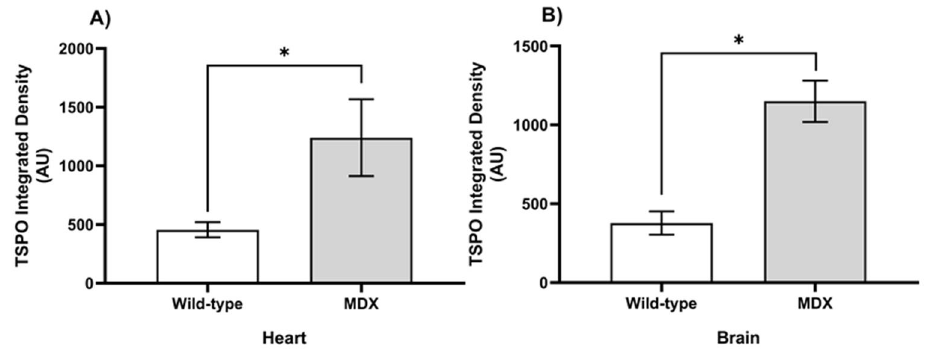
Figure 6. Quantified fluorescence immunohistochemical images of microglial and macrophages with TSPO in 8–10 weeks old MDX and wild-type subjects . Data (mean ± SE) depict higher TSPO in mdx:utrn (+/−) mice (gray bars) than wild-type controls (white bars) ( n = 3 mice/genotype). Signif- icant differences ( p < 0.05), indicated by *, were observed for slices of cardiac ( A ) and neural ( B ) tissue when compared using Welch’s two-way t -test ( n = 5–10 images/mouse/genotype). AU = arbitrary units. Other abbreviations as described in prior figures.